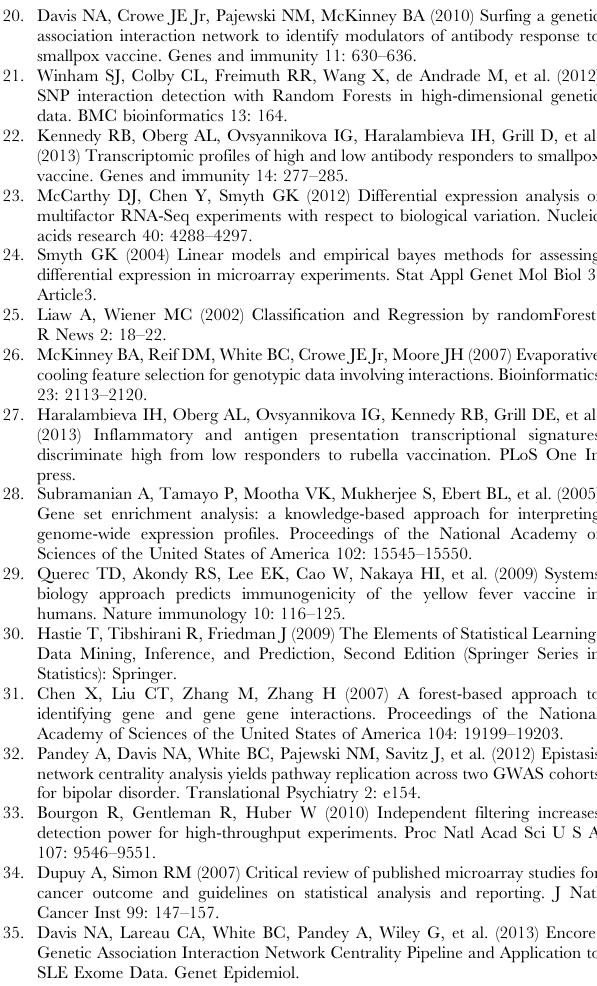
Table S3 Additional statistics on variation for the simulation results in Figure 7. The first column describes the effect of the gene in the simulated model: the fold change and negative binomial parameters. The remaining columns measure the mean, lower 5 th and upper 95 th percentile of the rank for the corresponding methods. The methods compared are Relief-F with optimized k nearest neighbors is compared with Random Jungle, Random Forest (R implementation), and tuned Random Forest with optimized